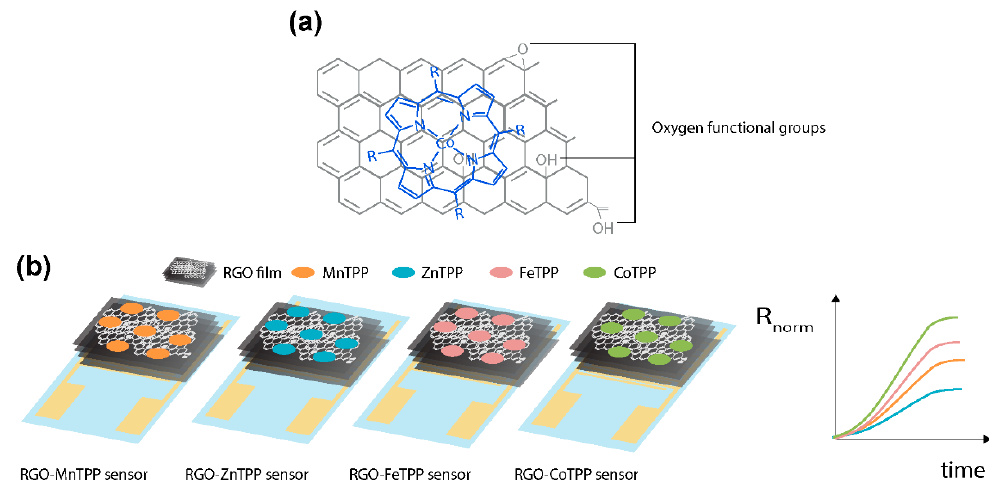
Figure 9. ( a ) RGO thin film samples were noncovalently functionalized by metalloporphyrin molecules (here, CoTPP), ( b ) RGO–metalloporphyrin sensors with different metalloporphyrins showed varying sensing responses.